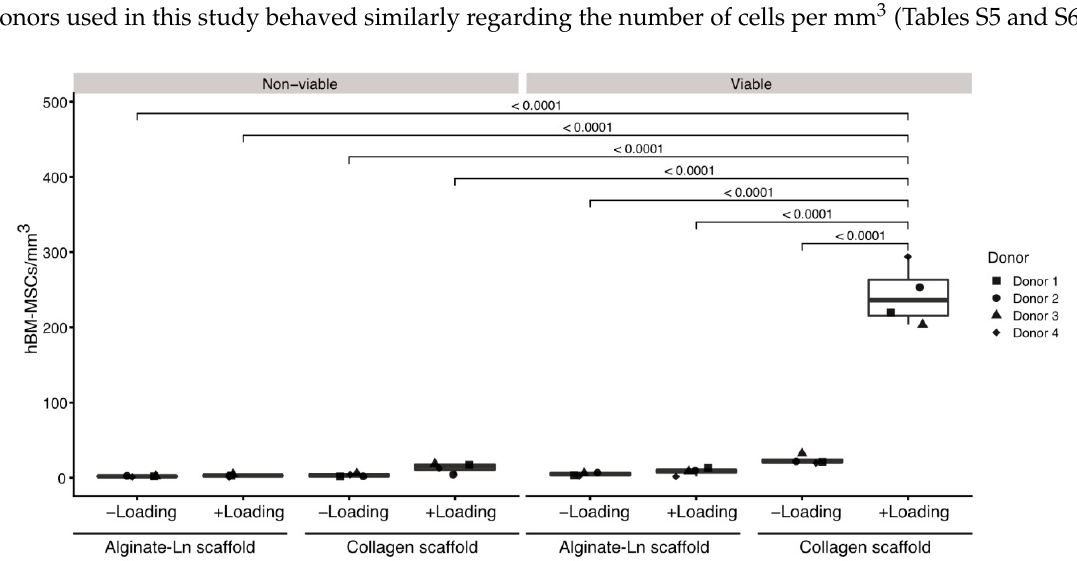
Figure 1. Comparison of cell counts per condition in alginate-Ln and col-I scaffolds. Mechanical loading, cell viability and type of the scaffold were statistically compared with respect to their cell counts. Col-I scaffolds contained more viable cells than alginate-Ln scaffolds. Unloaded conditions did not show significant differences in the amount of cells, independently of the viability or biomaterial of the scaffold. Examinations were done using cells from four different donors; every dot represents the mean of technical replicates. p -vales were estimated by a pairwise least square means comparison, and adjusted for multiple comparisons using Sidak’s correction.